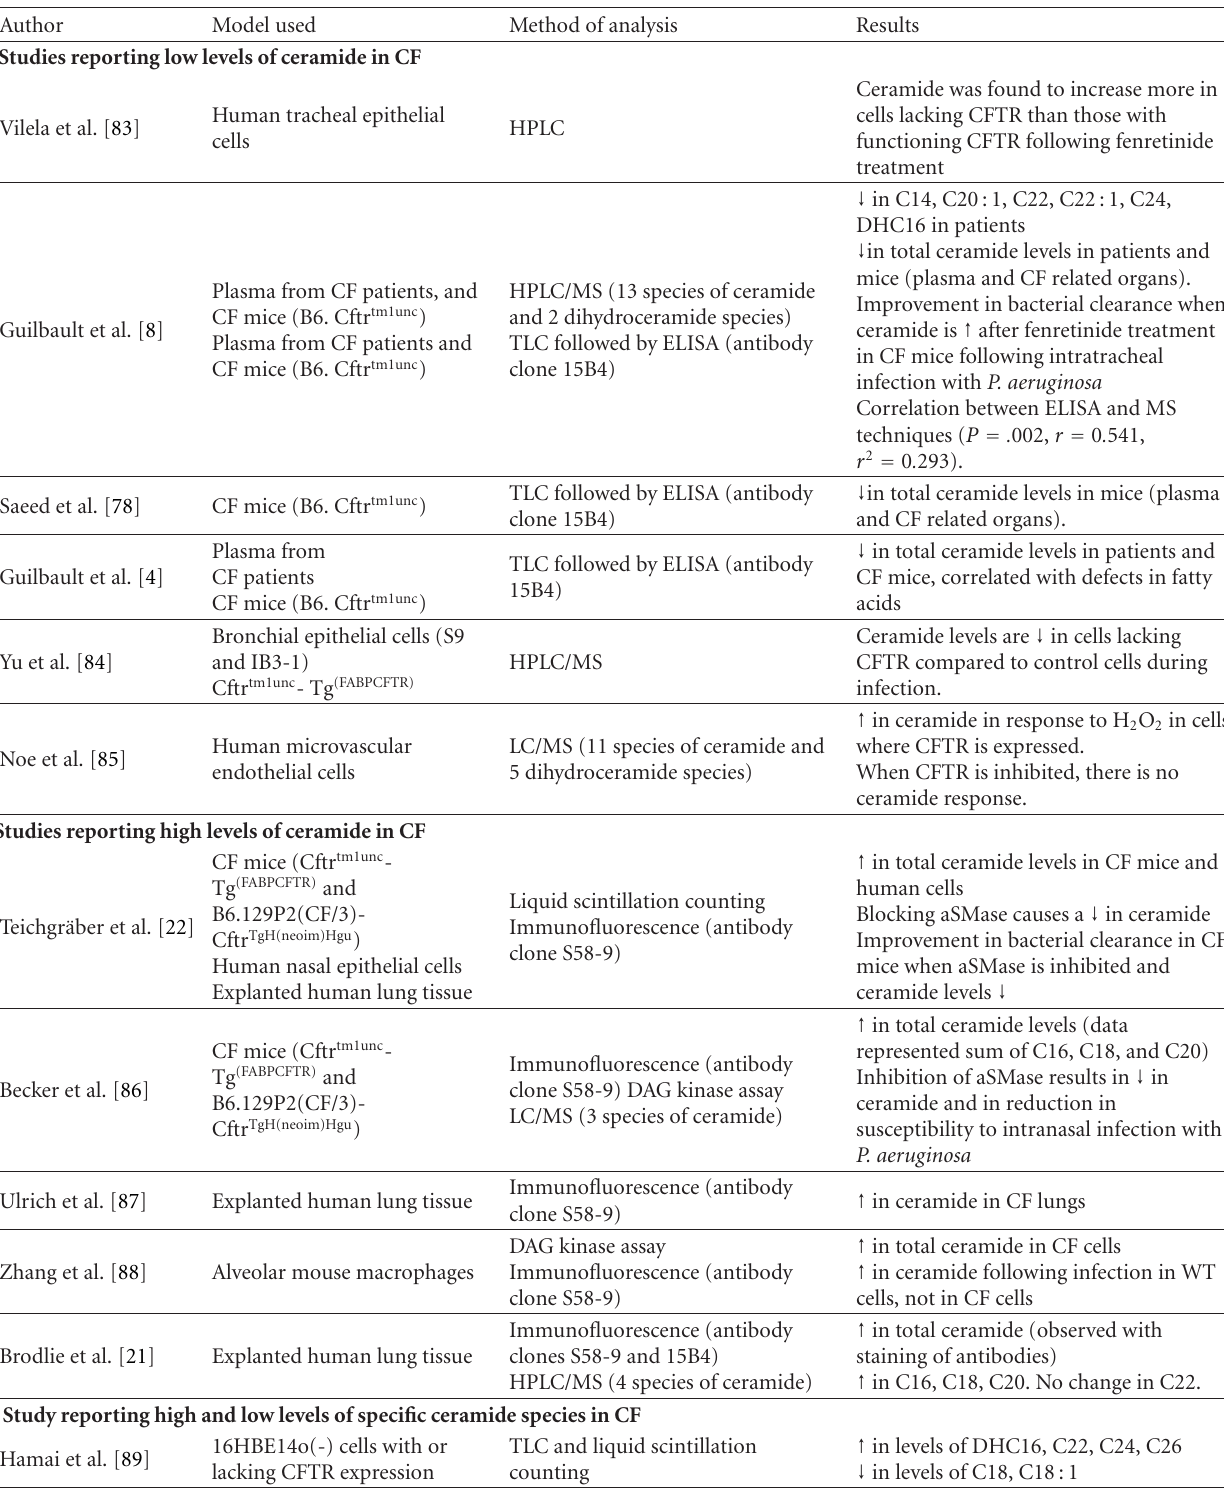
Table 1: Summary of studies on ceramide in cystic